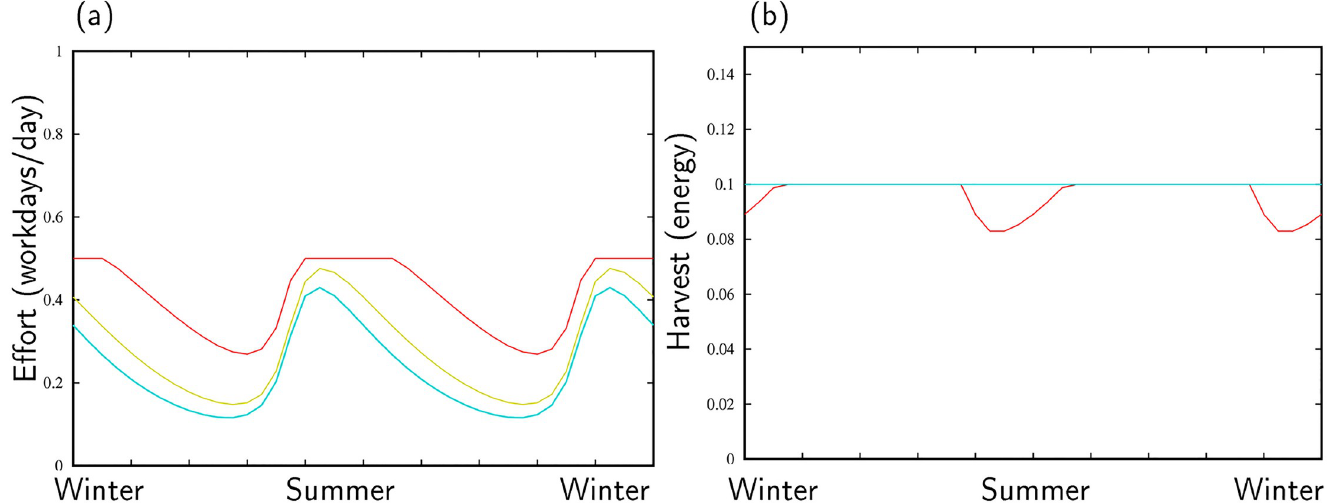
Fig 4. Foraging effort (a) and harvest (b) over a two-year period in habitat one for increasing population levels when foragers partition. Blue line– N i for all i = 1; yellow-green line– N for all i = 2; Red line– N for all i = 3.5. The dynamics in habitat 2 are identical. Note that the resource growth rate, r , and the minimum harvest i i level h , simply set the units for (or scale the) sustainable population size. Our choice to set h = 0.1, sets the sustainable population size to order 1 (individuals, m m households, village clusters, depending on the spatial scale of the habitat implied in the units of x i , etc.) α = 1.